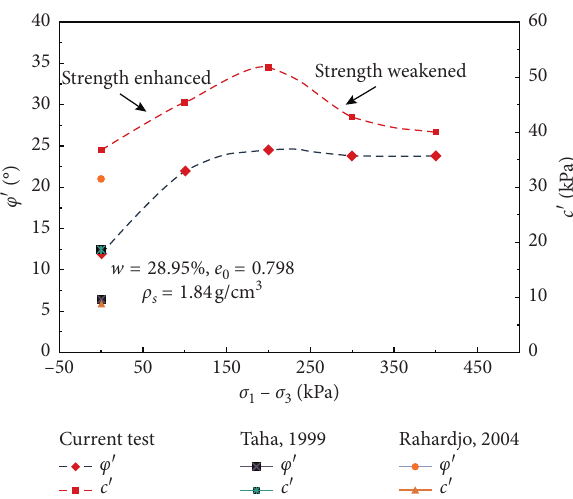
Figure 9: Shear strength vs. deviator stress in the two kinds of triaxial